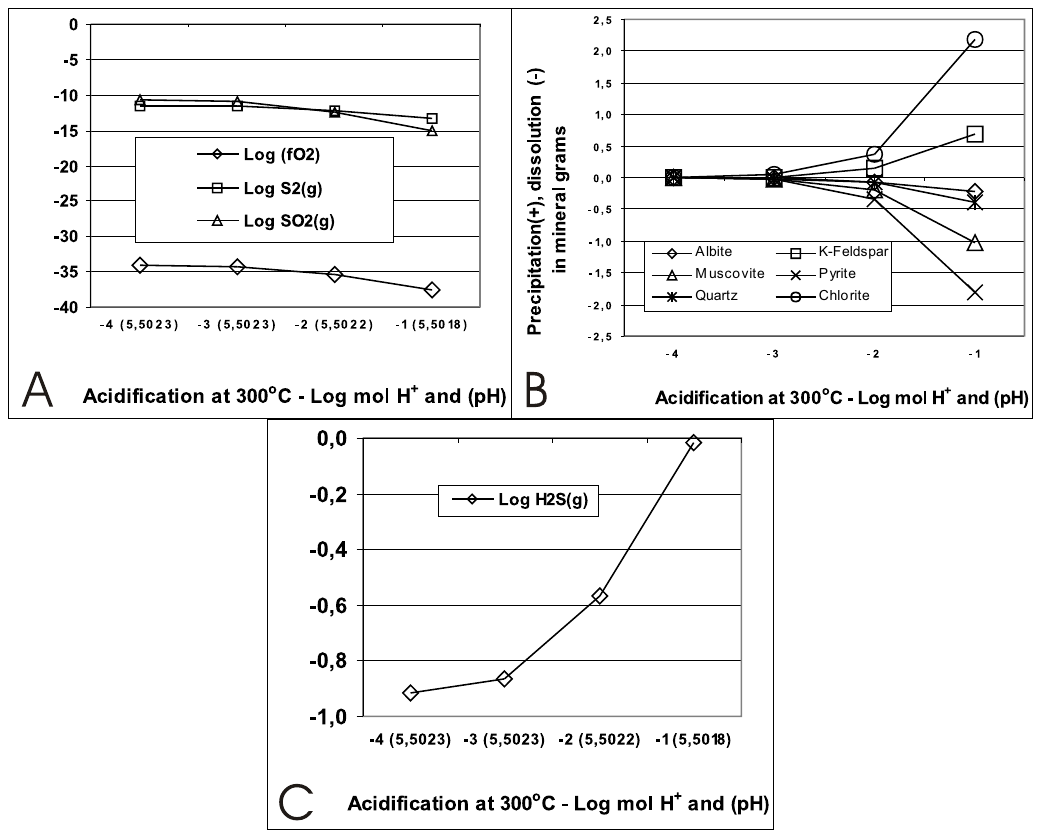
Fig. 5 – A – Behavior of the f O 2 and of S 2 and SO 2 (components of the solution), by the addition of H + . B – Variation in the precipitated (+) and dissolved (–) concentrations, in grams of mineral, by the addition of H + at 300 ◦ C. C – Variation of H 2 S in the fluid, by the addition of H + (gas pressure in